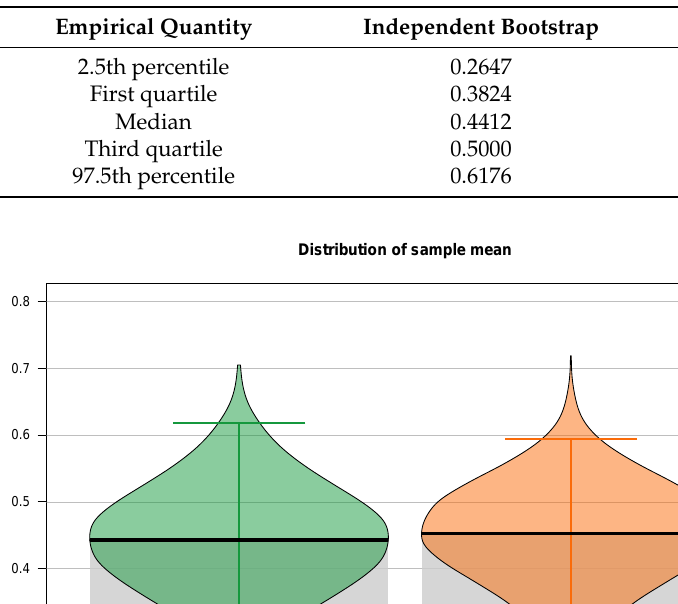
Table 1. Empirical distributional quantities of the sample mean based on the independent bootstrap (incorrect approach) against moving block bootstrap (proper approach) for the correct/incorrect answers by a subject from the Programme for International Student Assessment (PISA) 2012–U.S. Math Assessment; number of observations n = 34.